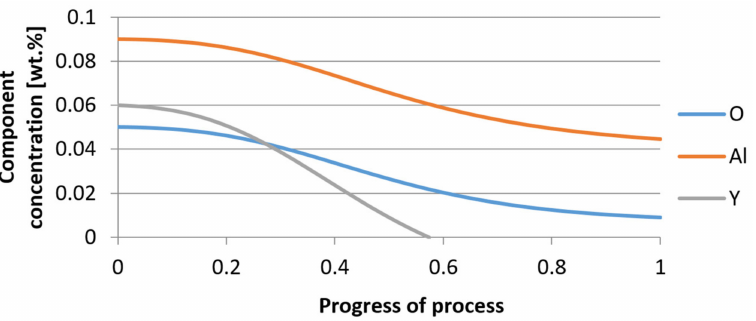
Figure 25. Change of component concentration during the growth of a bi-component nucleus (Al 2 O 3 –Y 2 O 3 ) in steel 2 (for r 0 = 5 µ